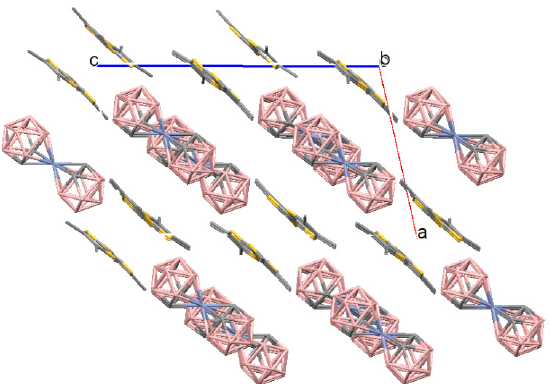
Figure 2. Crystal packing fragment of ( 1 ). A view along the b axis. The unit cell is outlined. H atoms are omitted for clarity.